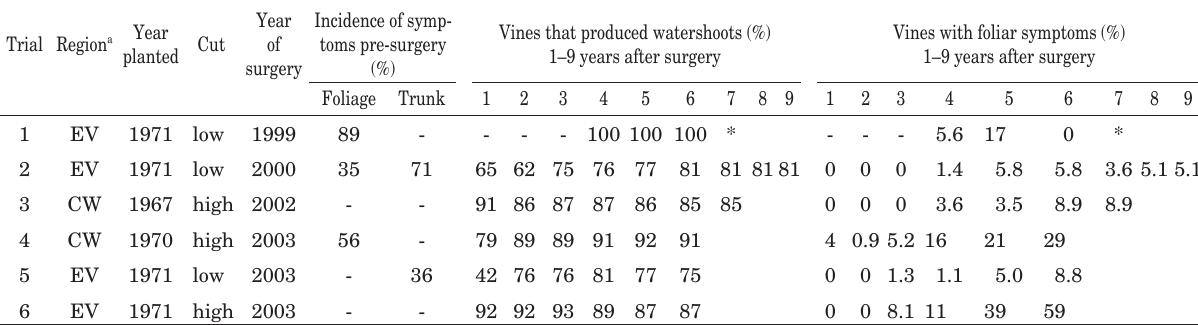
Vines with foliar symptoms (%) 1–9 years after